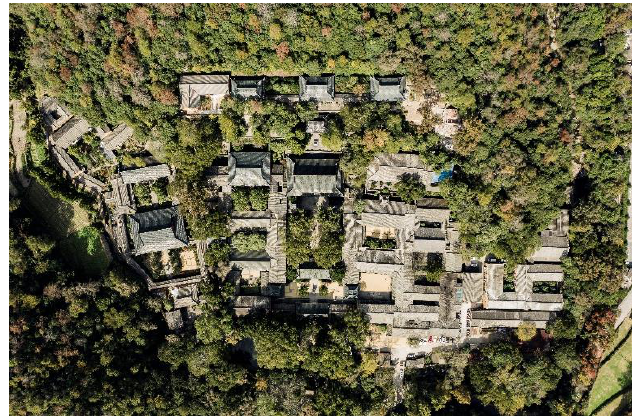
Figure 11. The Three Temples as the central axis.